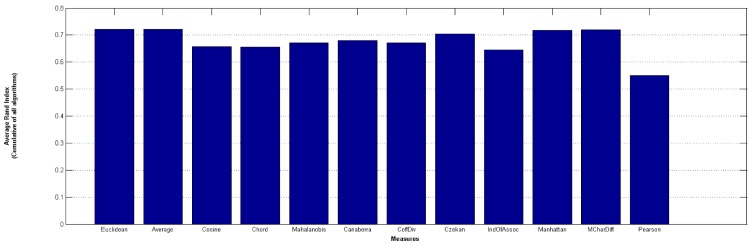
Overall RI Average.